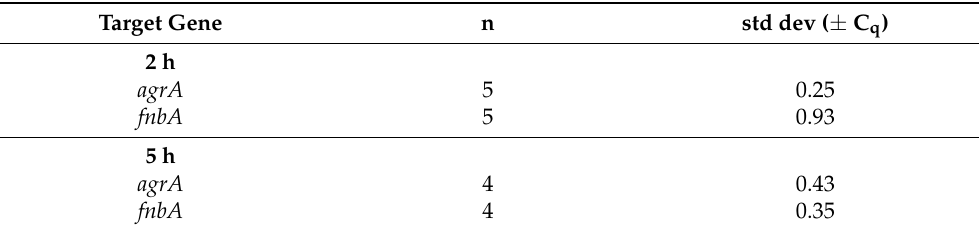
Table 5. Standard deviation of Cq values of target genes of S. aureus from culture after 2 h and 5 h of incubation (condition I). n: number of independent experiments carried out for each condition; std dev: standard deviation; C q : crossing point. n std dev ( ± C q )